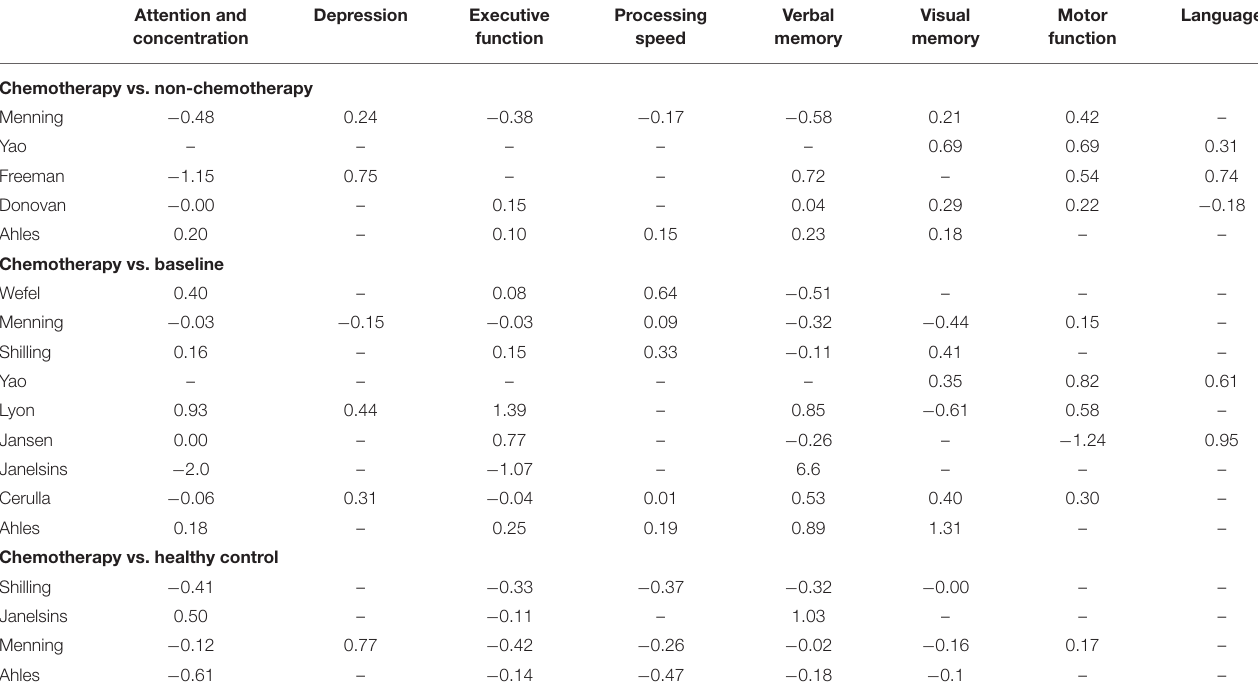
Depression Executive